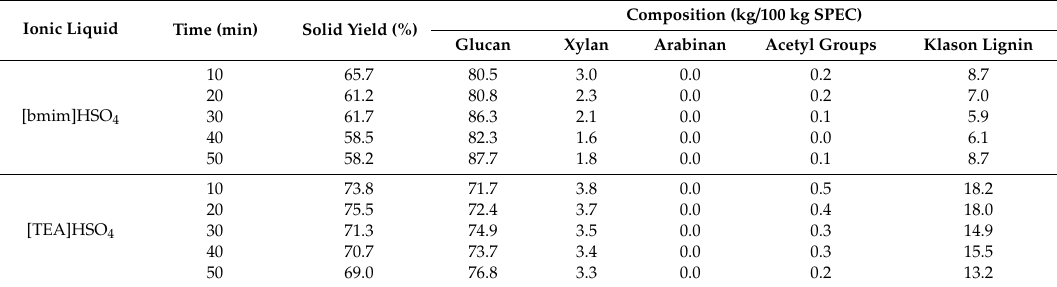
Table 1. Yield and composition of the solid phase enriched in cellulose obtained upon delignification (SPEC stream in Figure